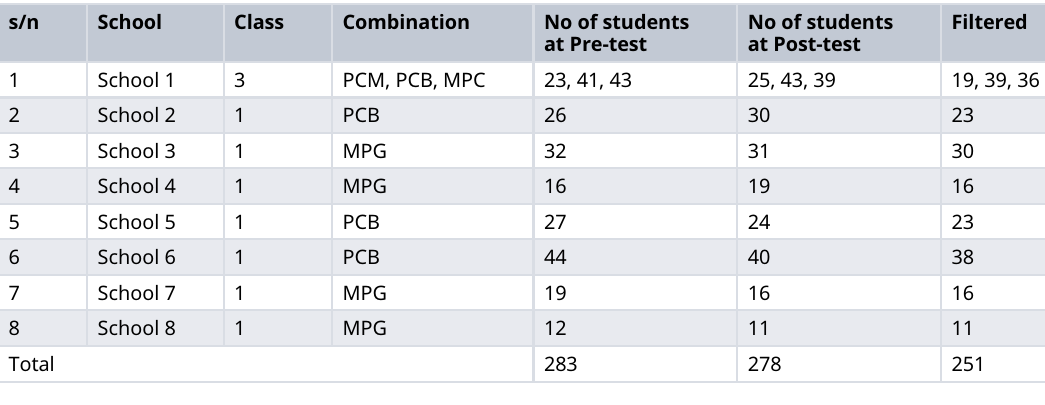
Table1.CharacteristicsofdatafortheLightPhenomenaConceptualAssessment(LPCA)implementedatS5or Grade11. Note:PCM:Physics-Chemistry-Mathematics, PCB:Physics-Chemistry-Biology,MPC:Mathematics-Physics-